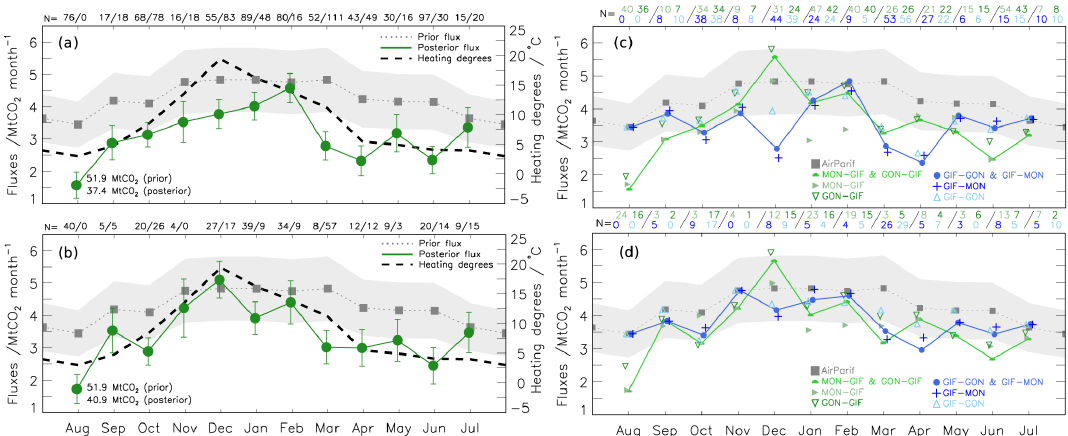
Figure 3. Monthly fossil fuel CO 2 emissions prior and posterior estimates from inversions in MtCO 2 . Left-hand panels: prior estimates (dashed grey line) ± the standard deviation of uncertainties (shaded area) and posterior estimates (green line) ± the standard deviation (green bars). (a) Results using the initial inversion configuration. (b) Results using the reference inversion configuration. Monthly mean heating degrees (dashed black line) for the centre of Paris as obtained from ECMWF’s operational analysis. Numbers at the top show CO 2 mole fraction gradients assimilated for SW or NE winds, respectively. Prior and posterior annual emission estimates are displayed in the bottom left-hand corner of each panel. Right-hand panels: results using the (c) initial and (d) reference configuration of the inversions but assimilations of only subsets of selected gradients (see Sect. 2.2.) Colour-coded numbers at the top are those of the assimilated gradients. Prior estimates (dashed grey line) ± the standard deviation of uncertainties (shaded area). Symbols are shifted slightly to prevent